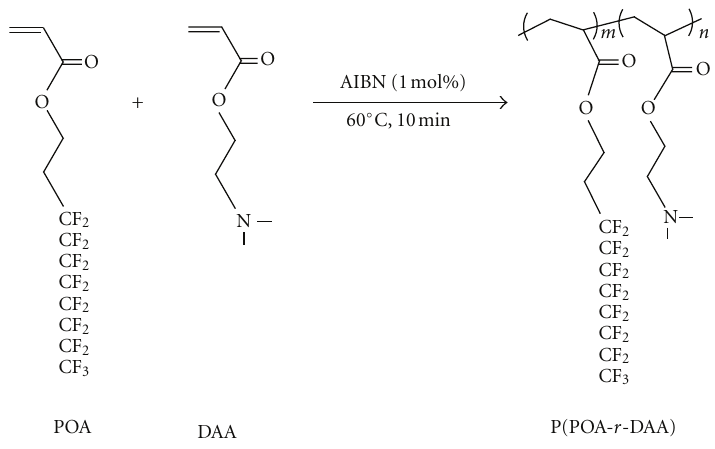
Scheme 5: Synthesis of the P(POA- r -DAA) random copolymers.